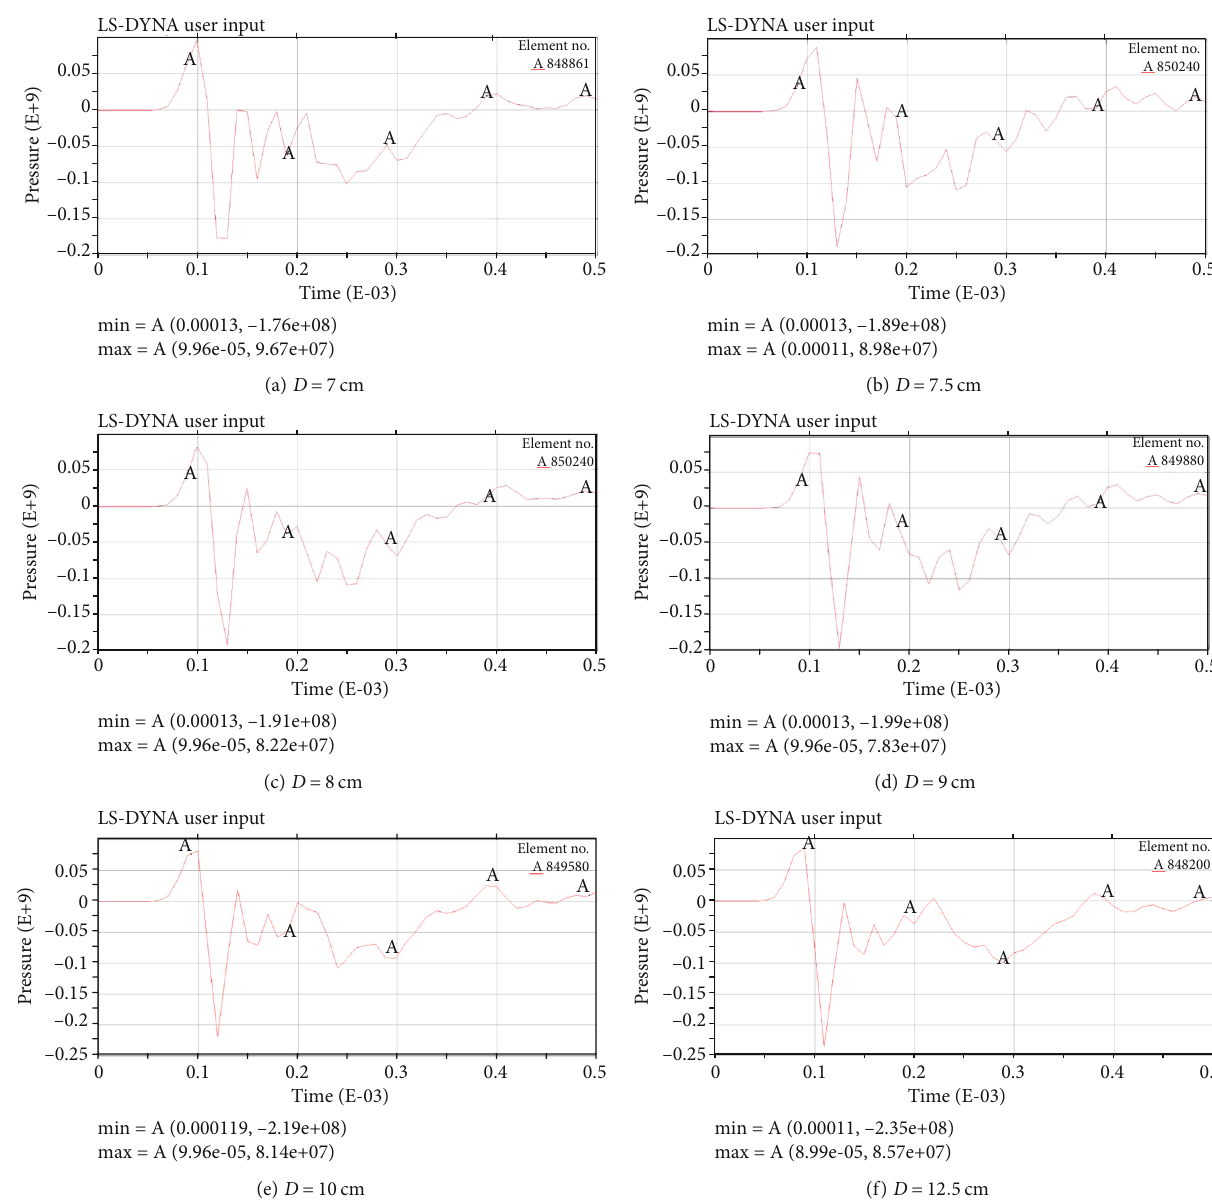
Figure 2: Pressure time history curve of hole wall under di ff erent hole